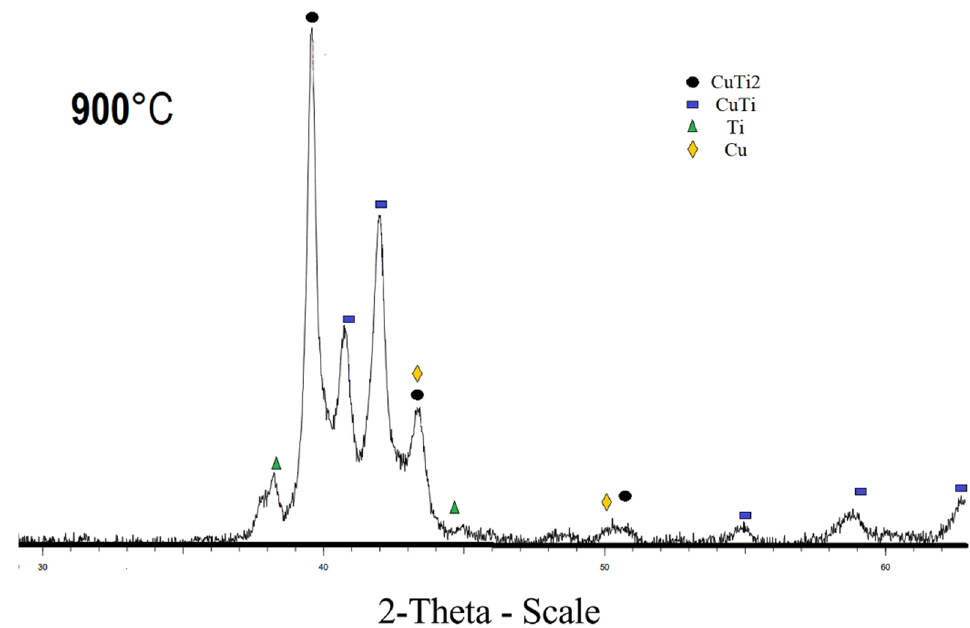
Figure 4. X-ray pattern of specimen obtained at 900 °C. Table 2. Weight configuration of